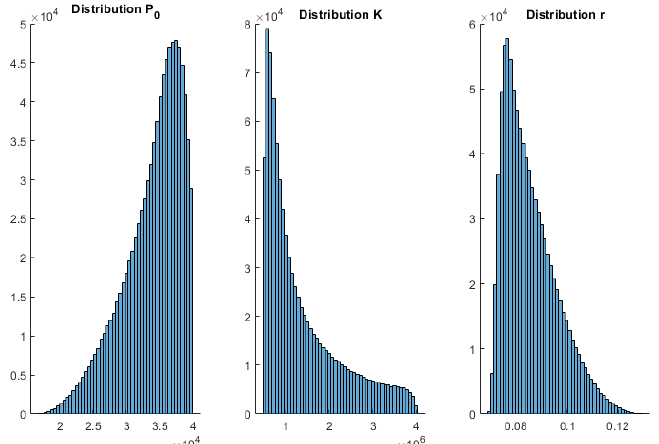
Figure A1. Histograms 5 January 2021 wave 3 Verhulst—Spain.